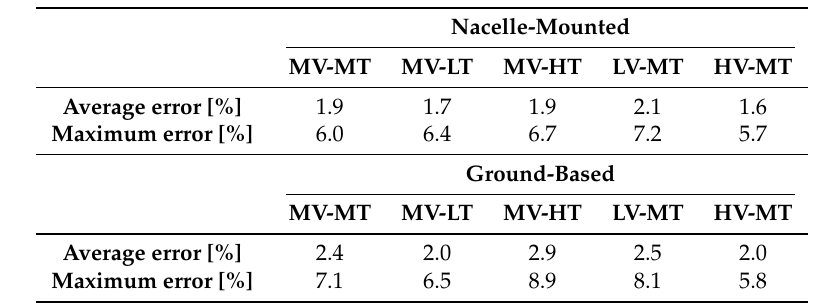
Table 6. Total average and maximum errors for the reconstruction of σ u ( x , y , z ) inside the volume of interest for all inflow cases studied and both lidar locations with the overall optimum angular resolution of 3 ◦ . The errors are shown as a percentage of the undisturbed wind speed at hub height (see Section